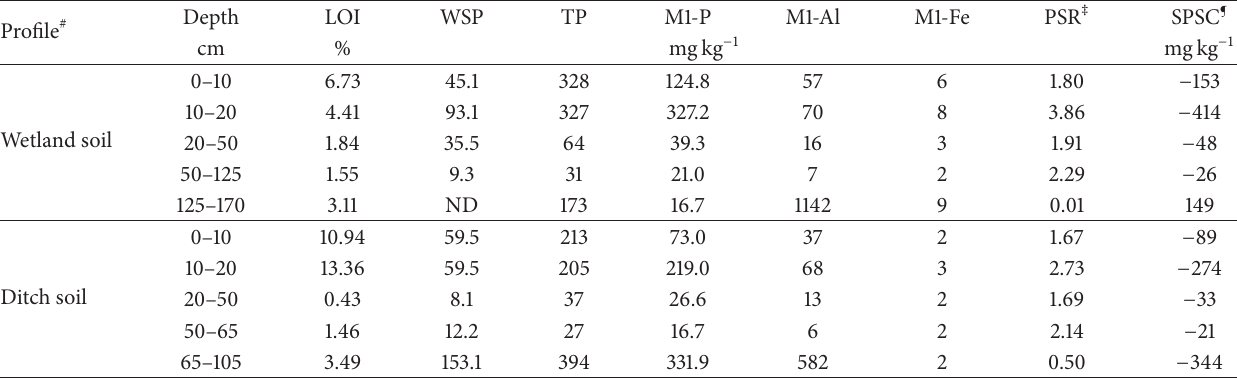
Table 3: Selected soil characteristics † of wetland and ditch soil samples collected to a depth of at least 1m. Source: [34]. Depth LOI WSP TP M1-P M1-Al M1-Fe PSR ‡ SPSC ¶ Profile # cm % mg kg −1 mg kg −1 0–10 6.73 45.1 328 124.8 Wetland soil